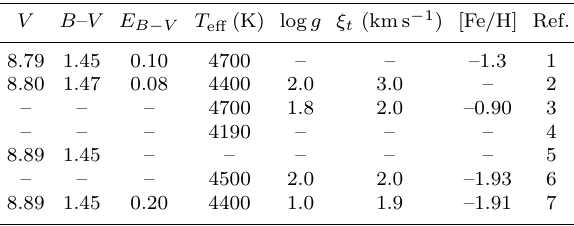
Fig. 1. Observed spectrum of HD 209621 (dots) in the wavelength region less affected by molecular features. The important lines are identified by their chemical symbol. The synthetic spectrum is given for selected lines, calculated using the final atmospheric parameters and abundances. Table 1. Basic data for HD 209621, available in